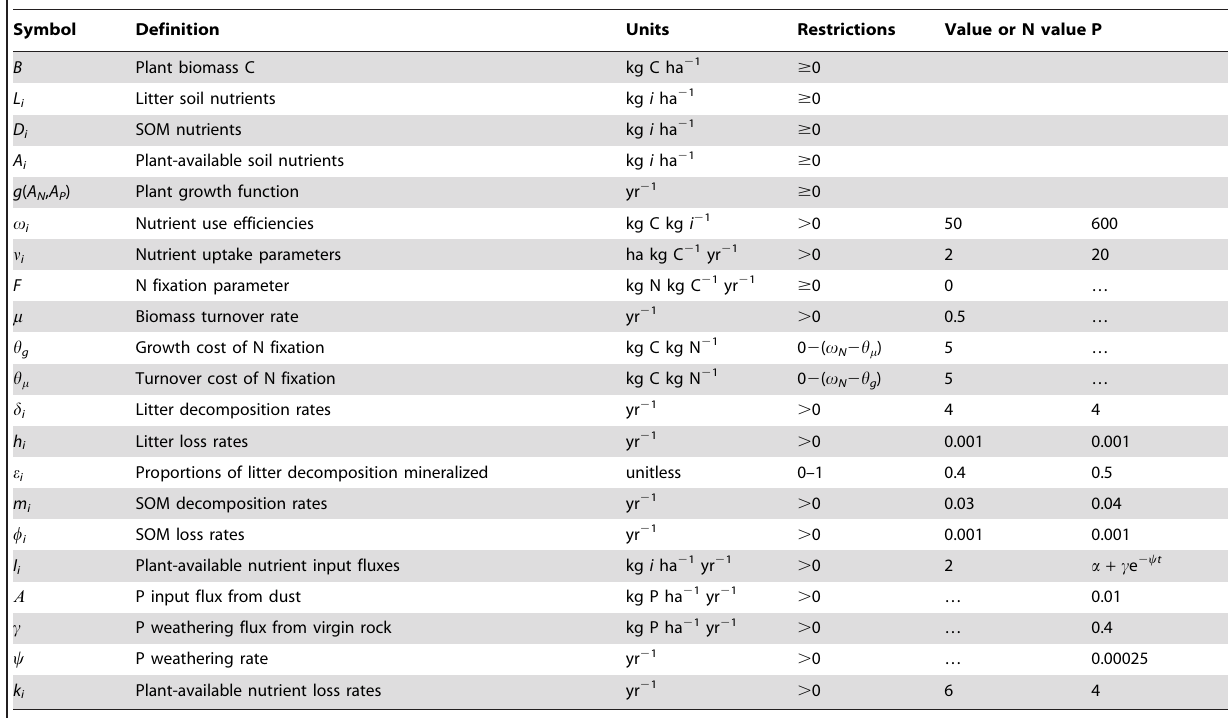
Table notes: i refers to nitrogen (N) and phosphorus (P). C: carbon. SOM: soil organic matter. Parameters are from [40], except for d i and m i (adapted from m in [40] to account for two soil organic pools per nutrient here rather than one), h i (chosen to equal Q i ), e i (reasonable guesses), k i (adjusted to reflect greater N than P loss due